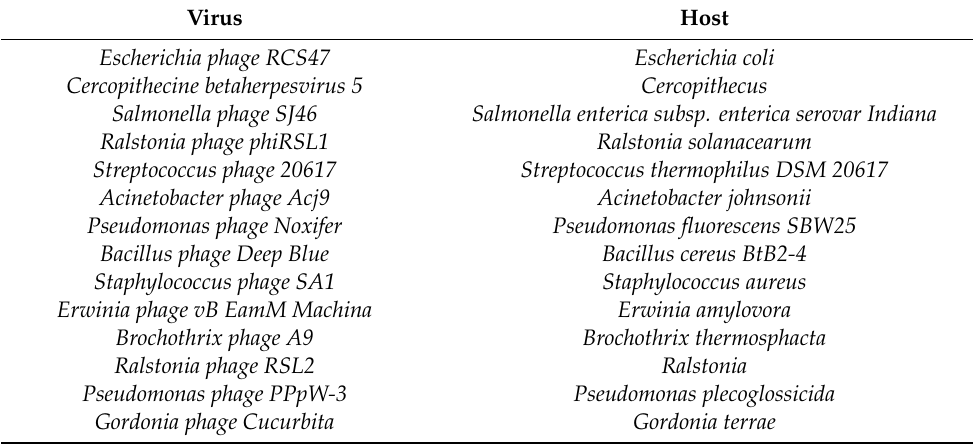
Figure 7. The heatmap of annotated dominant viral species in each well. Table 3. The annotated dominant viral species and corresponding host for all wells.